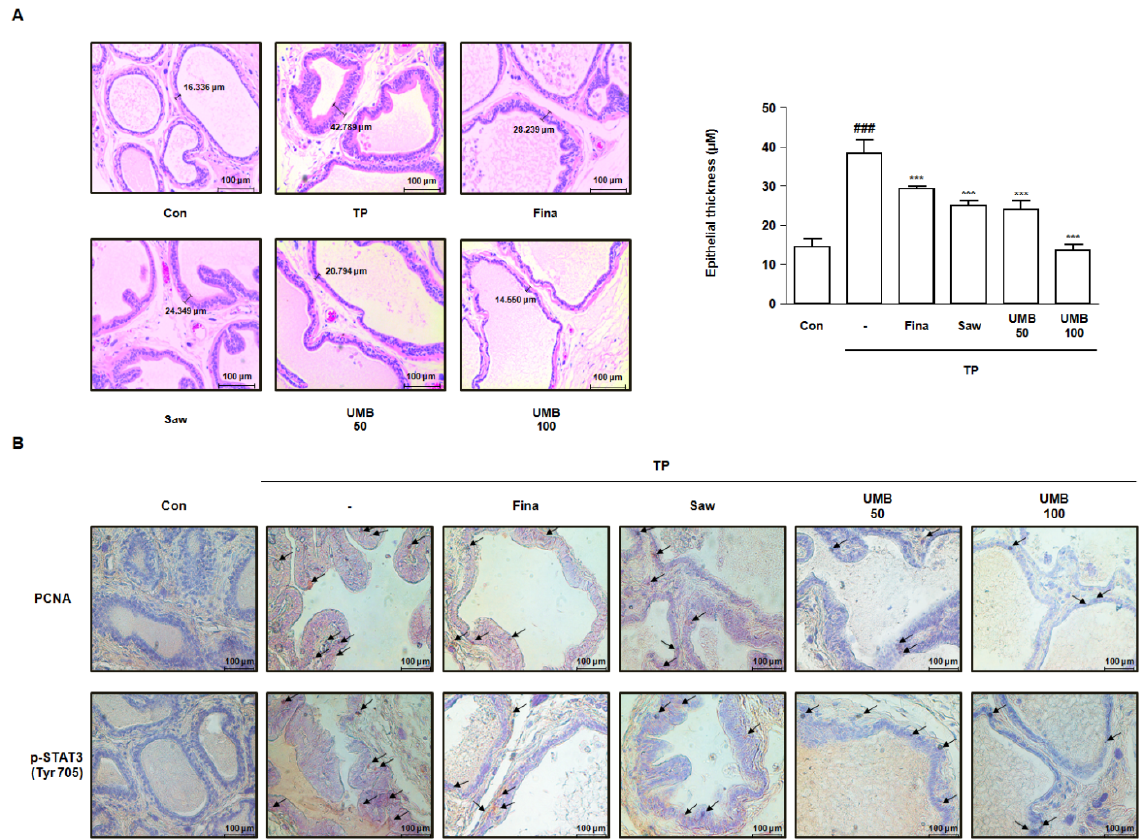
Figure 6. Effect of UMB on histological alterations in TP-induced rats. ( A ) Prostate tissue sections stained with hematoxylin and eosin (H&E) were observed using a Leica microscope (original magnification 20 × ). Epithelial thickness in the prostate tissues was measured and represented as the mean ± S.D. of five rats per experimental group. The expression of ( B ) PCNA and p-STAT3 (Tyr 705) was detected in prostate tissue of rats by immunohistochemical analysis using a Leica microscope (original magnification 20×). The black arrows indicate the immunoreactivity of PCNA and p-STAT3 (Tyr 705) highlighted in the prostate tissues of each group. ### p < 0.001 vs. Con group; *** p < 0.001 vs. TP group.